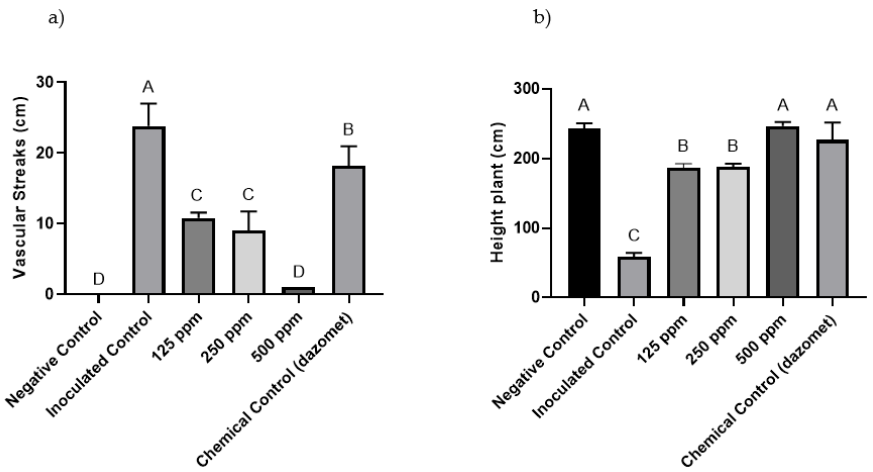
Figure 4. ( a ) Effect of the different concentrations of nanoemulsion (ppm) on the length (cm) of the vascular streaks observed in ‘Naomi’ tomatoes inoculated with Forl (PUCVToF 1915). ( b ) Effect of the different concentrations of nanoemulsion (ppm) on plant height (cm) of ‘Naomi’ tomatoes inoculated with Forl (PUCVToF 1915). Means with different letters indicate significant differences from each other ( p ≤ 0.05).